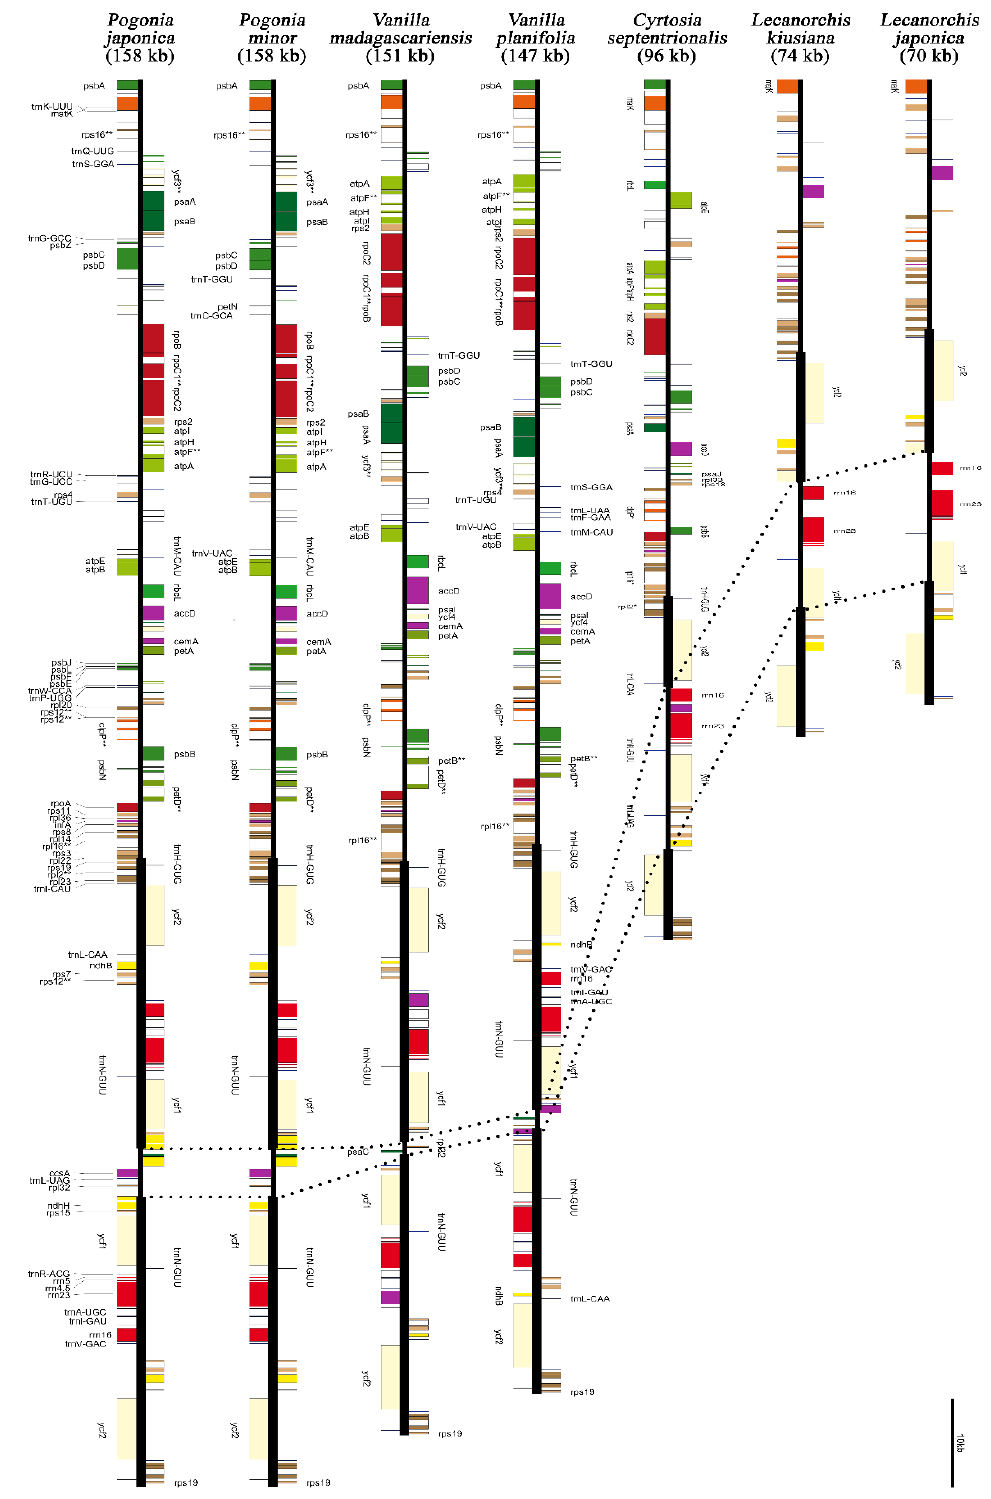
Figure 2. Seven representative plastomes of Vanilloideae. Pogonia japonica has the longest plastome, with 158.2 kb. Pogonia and Vanilla are the photosynthetic species, while Cyrtosia and Lecanorchis are the nonphotosynthetic mycoheterotrophic species. A few photosynthesis-related genes or pseudogenes remain in Cyrtosia , while all photosynthesis-related genes have been lost in Lecanorchis . Green gene boxes indicate genes related to the light reaction of photosynthesis. L . kiusiana and L . japonica hold only 33 and 32 gene regions, respectively. The heavy vertical lines indicate inverted repeat (IR) regions. The dashed lines indicate the single copy (SSC) regions.